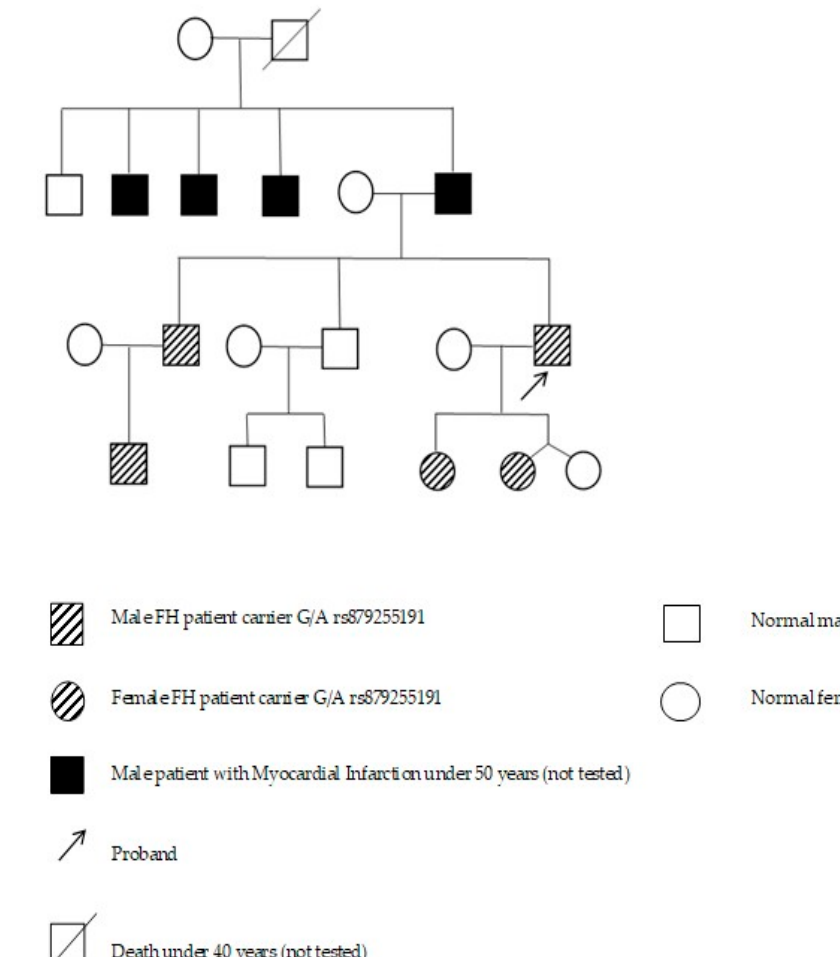
J. Pers. Med. 2021 , 11 , x